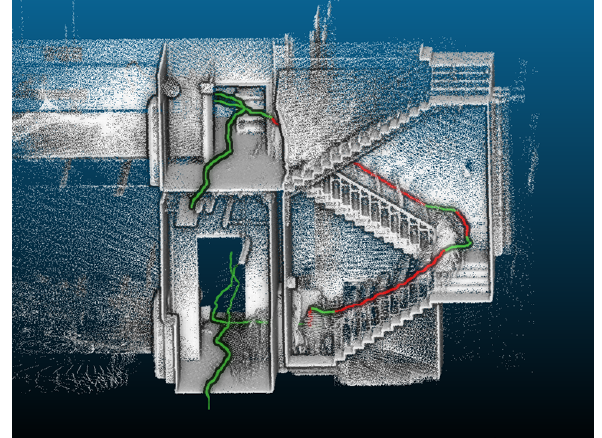
Figure 2. Analysed trajectory in the point cloud: green represents a flat surface and red represents a stair